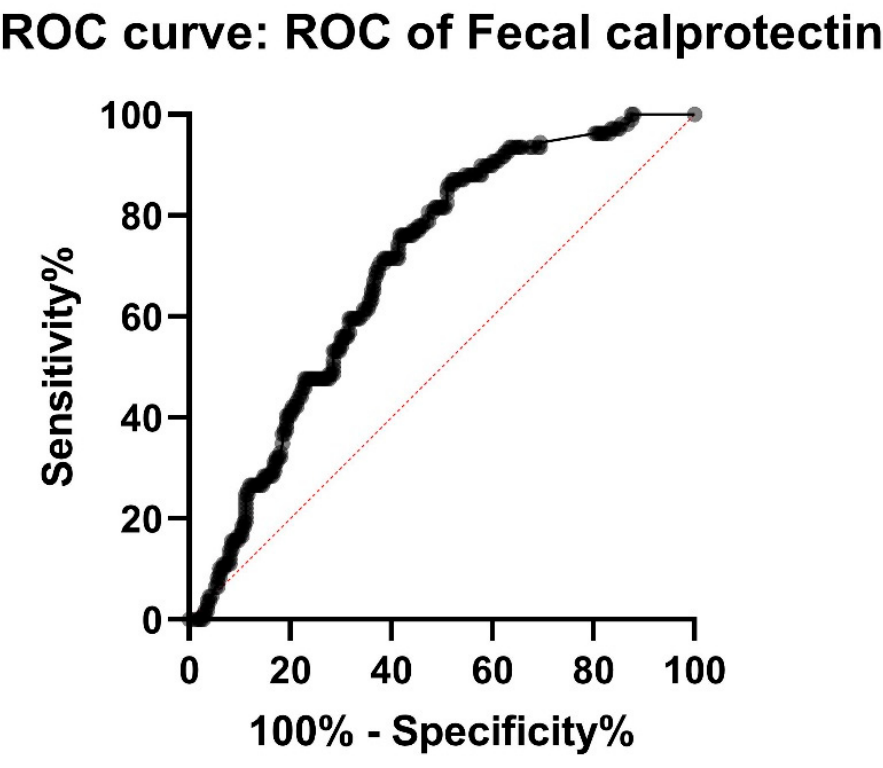
Figure 2. ROC (receiver operating characteristic curve) for FC (fecal calprotectin) shows AUC (area under curve) of only 0.69, meaning relatively low sensitivity and specificity of FC in the diagnostics of small bowel CD (Crohn ′ s disease).